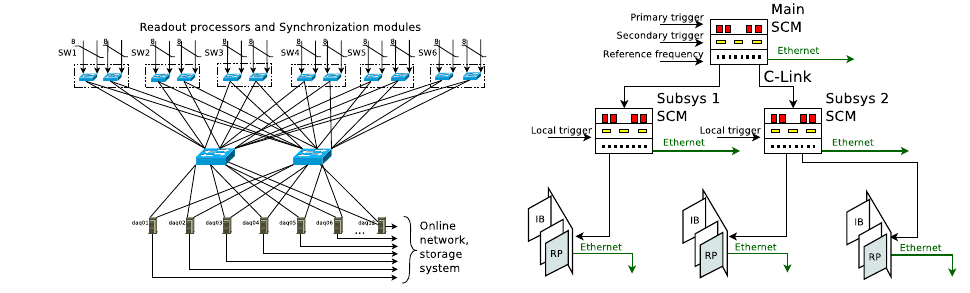
Figure 4. DAQ network and cluster scheme. Figure 5. Synchronization and commands distri- bution